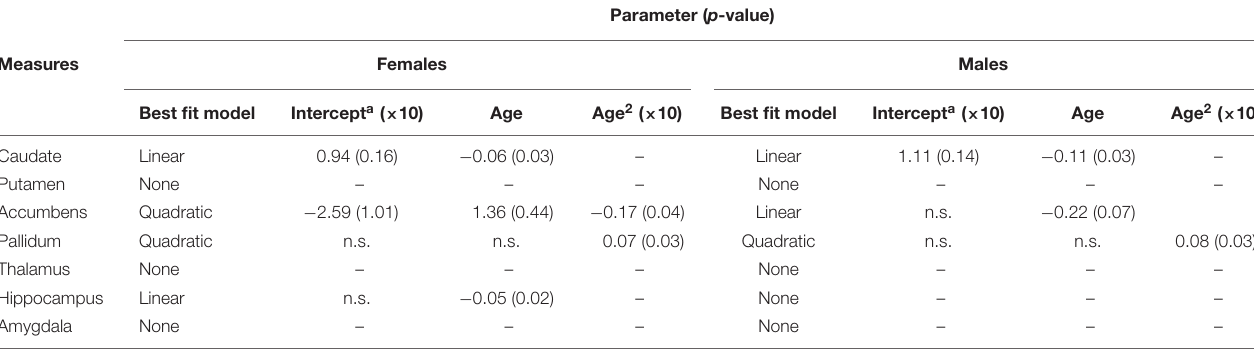
FIGURE 5 | The age trajectories of subcortical asymmetries, including the (A) caudate, (B) accumbens, (C) pallidum, and (D) hippocampus in females (red color) and males (blue color). TABLE 5 | Fitting parameters for asymmetries of subcortical structures versus age in females and